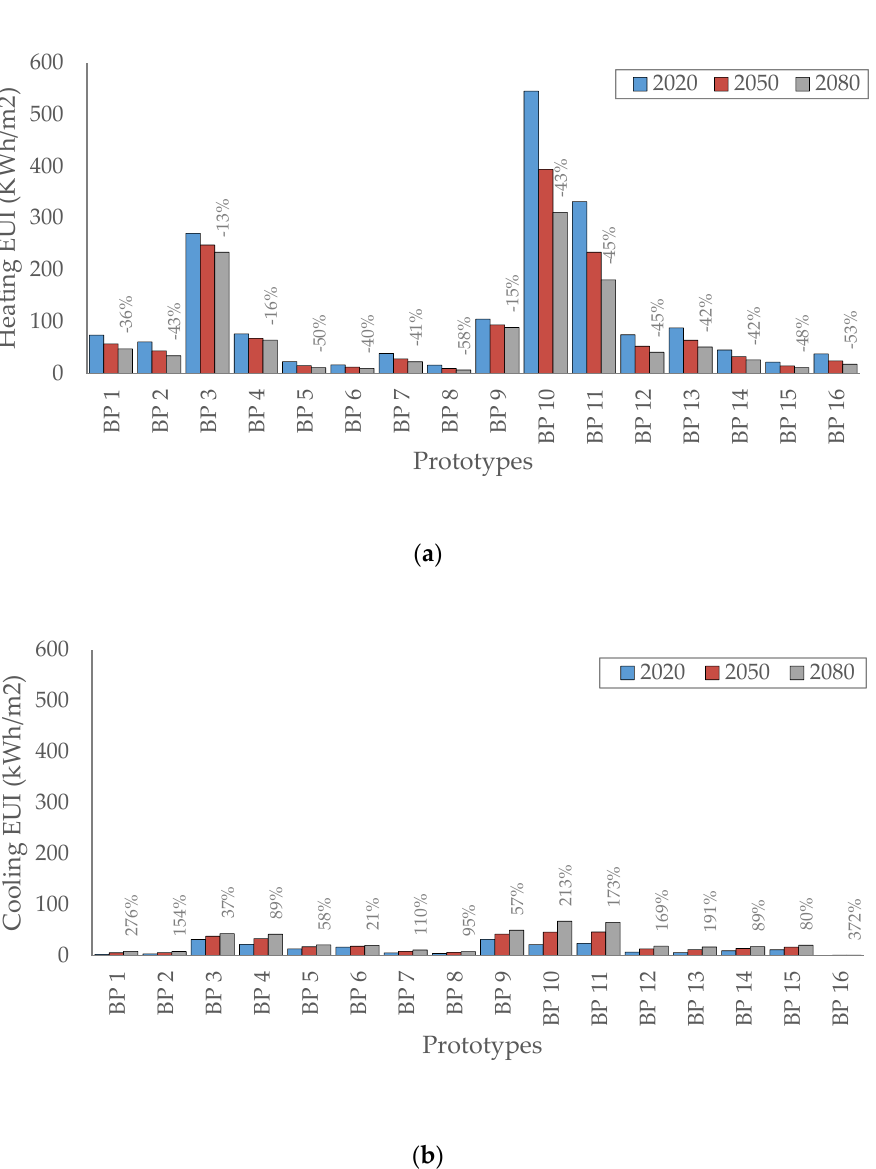
Figure 6. Heating EUI ( a ) and cooling EUI ( b ) in building prototypes from 2020 to 2080; the numbers demonstrate relative changes of values for 2080 compared to 2020.